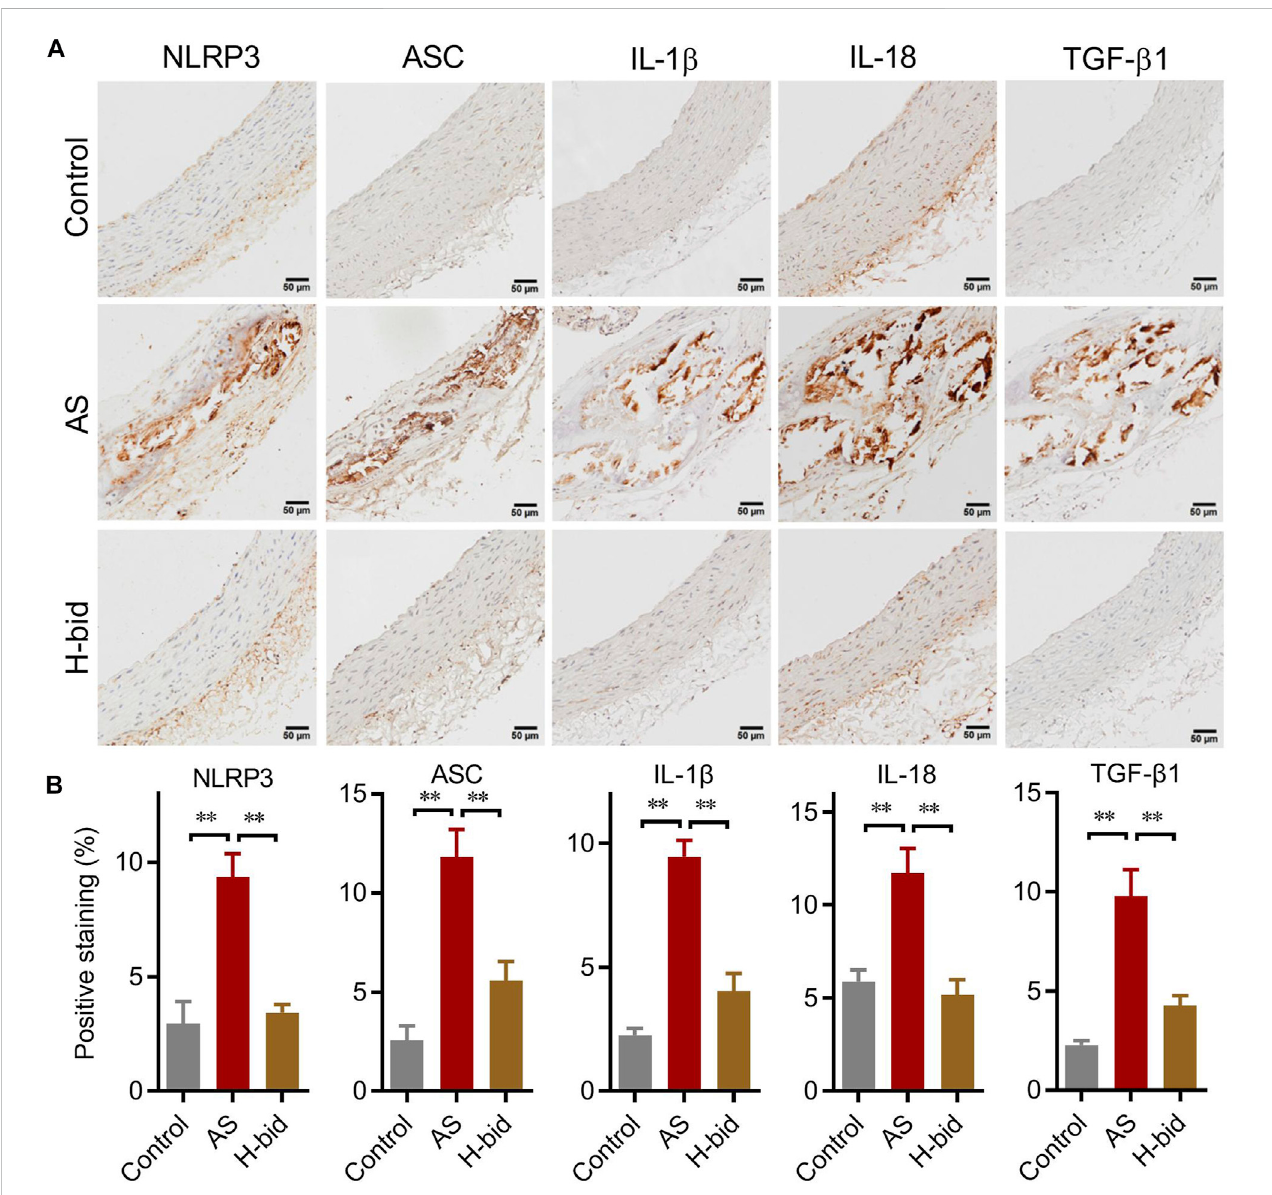
FIGURE 5 Art inhibits the arterial NLRP3 in fl ammasome – TGF- β 1 pathway in AS rats. (A) IHC staining of arterial sections. IHC experiments were performed by using antibodies against NLRP3, ASC, IL-1 β , IL-18, and TGF- β 1 (Bar = 50 μ m). (B) Percentages of positive staining ( n = 5). ** p <